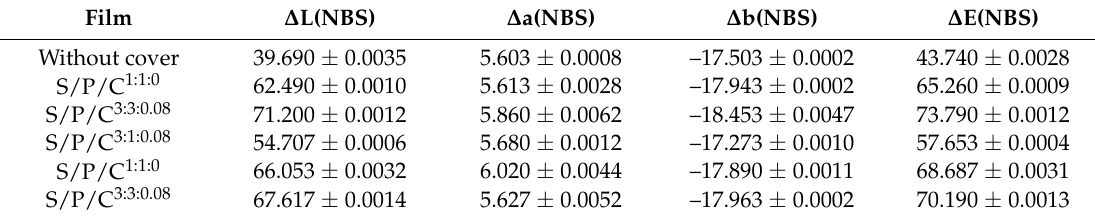
Table 2. Test of the color differences of starch/polyvinyl alcohol/citric acid ternary blend functional food packaging